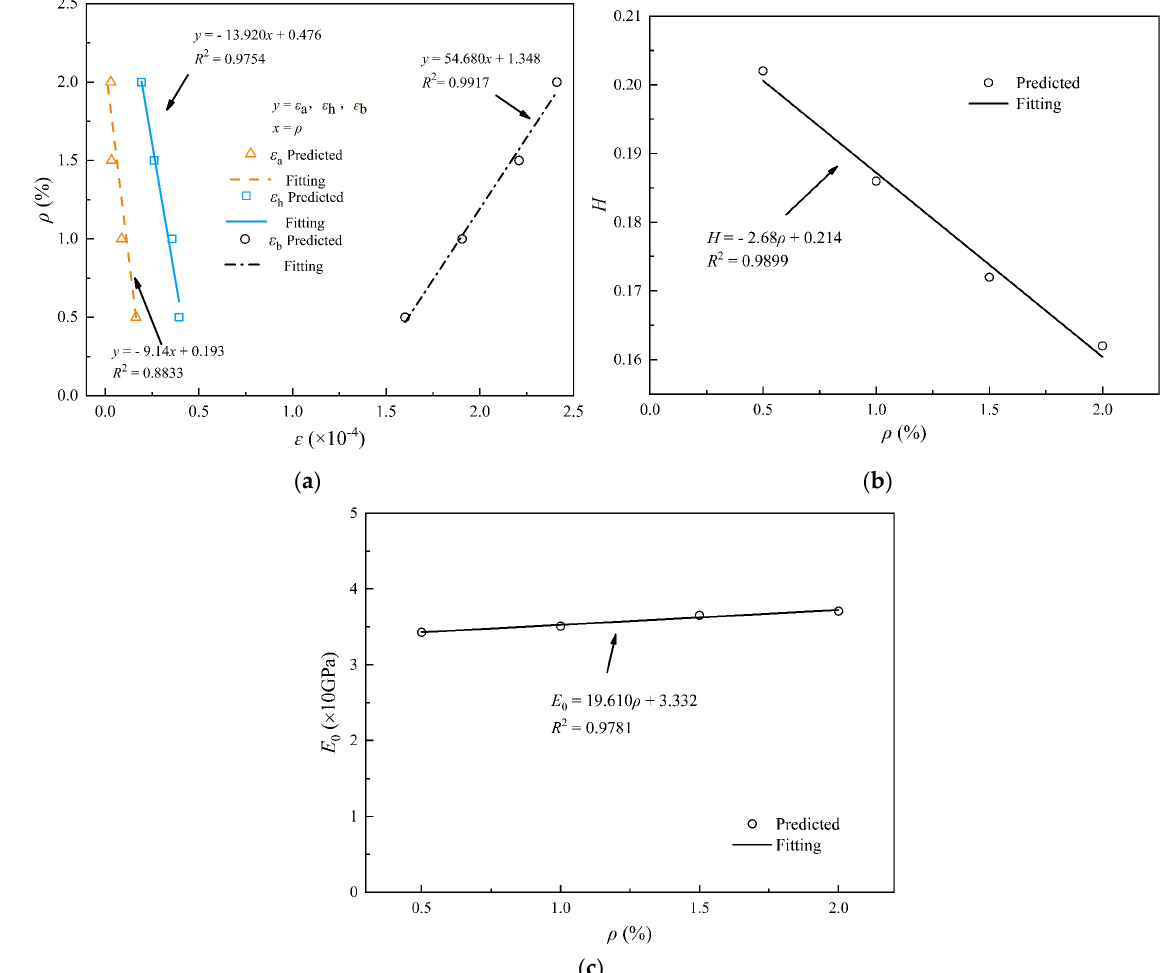
Crystals 2021 , 11 , x FOR PEER REVIEW Figure 12. Influence of fiber volume fraction on the characteristic parameters: ( a ) ρ - ε a , ε h , ε b curves; ( b ) H - ρ curve; ( c ) E 0 - ρ curve.